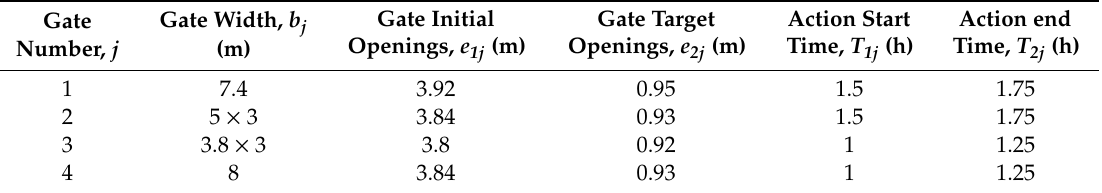
Table 3. Gates schedule of the test scenario.